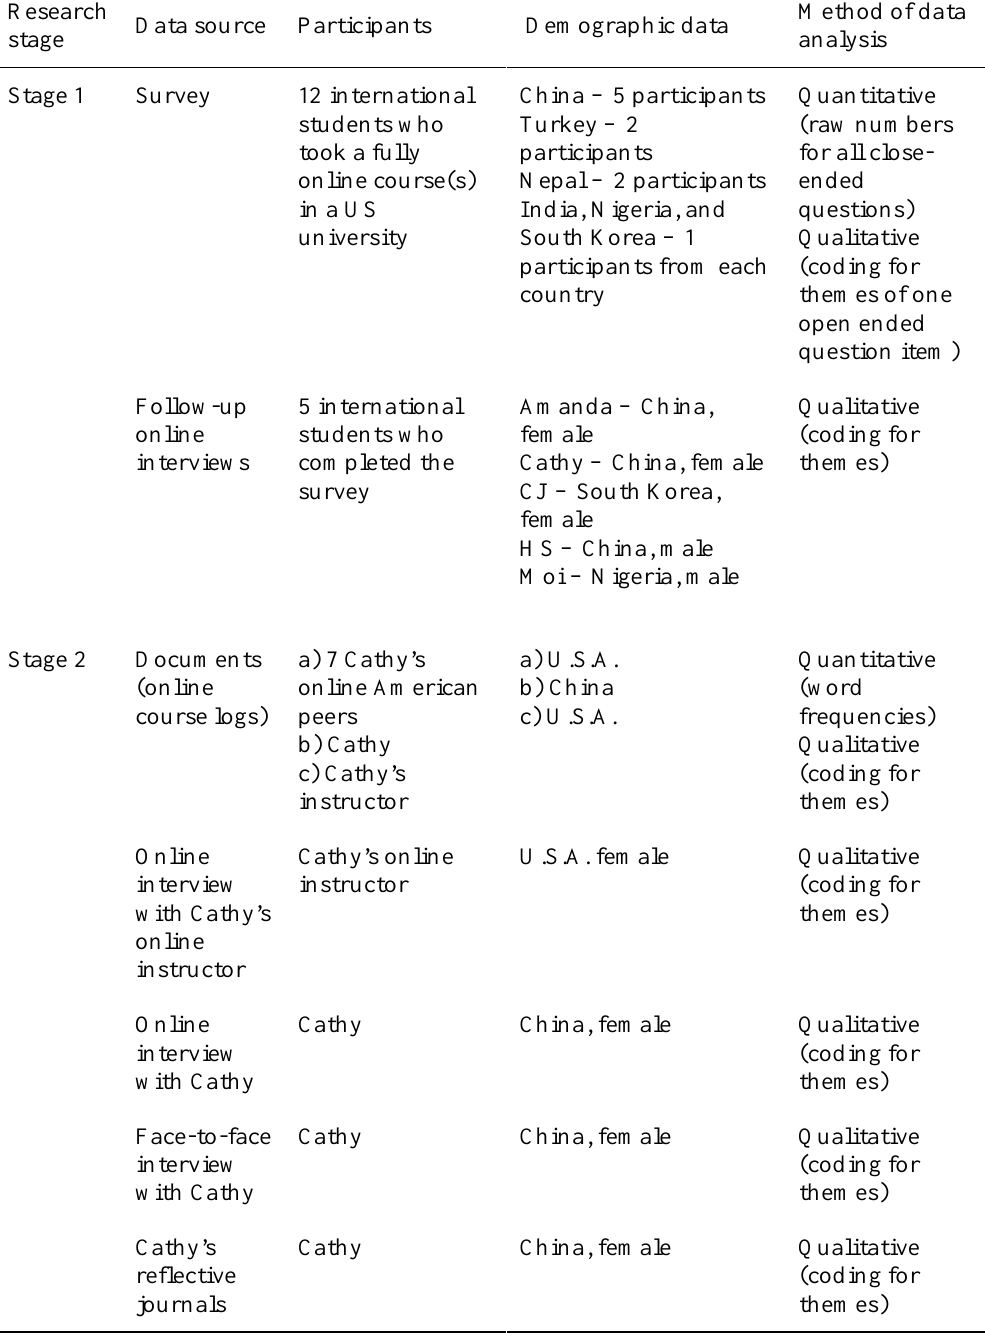
Table 1 Data Sources, Participants, Demographic Data, and Methods of Data Analysis